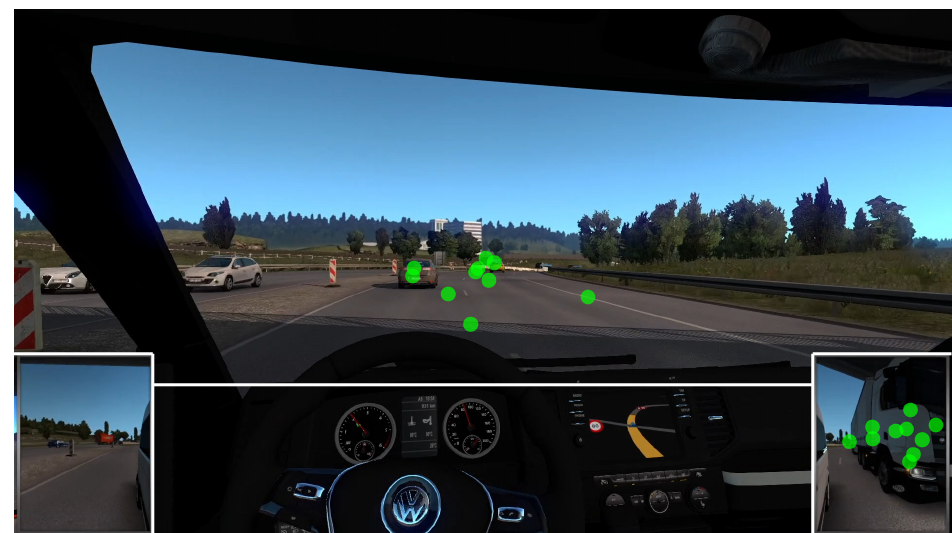
Figure 6. Moment in Video 3 where most participants attended to the right mirror (Baseline Task). The green markers represent the gaze coordinates of individual participants. White lines are drawn around the AOIs.